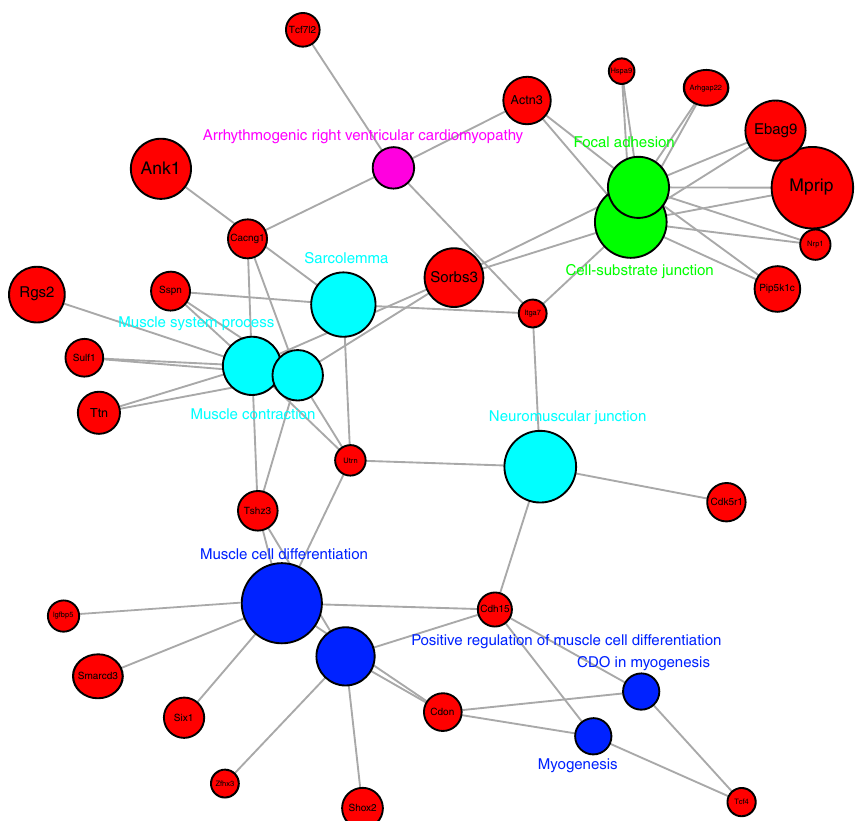
Fig. 4 Pathways signi fi cantly downregulated by Ash1L ablation. Bipartite graph showing signi fi cantly enriched categories (KEGG, Biocarta, WikiPathways, Reactome, GO BP/MF/CC) (FDR <0.05, Z -score < − 1.75, and n ≥ 3) and their associated genes within the 100 downregulated genes (FDR <0.1) in Ash1L KD myoblasts. The size of the gene nodes is proportional to the log 2 FC of downregulation, while the size of the category nodes is proportional to the signi fi cance of enrichment ( − log 10 Adj. p